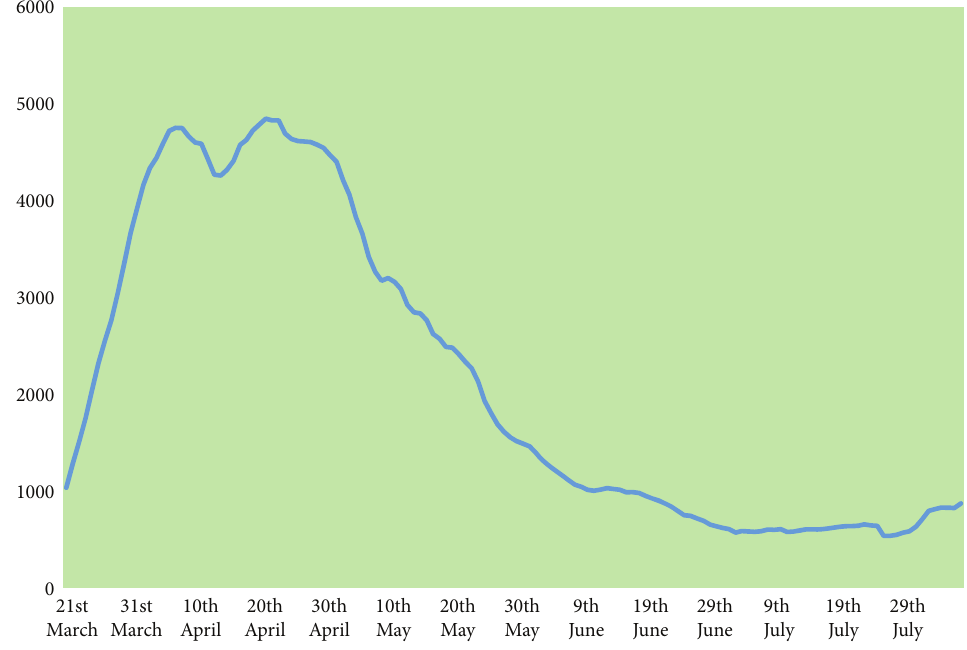
Figure 3: Seven-day moving average new cases, UK COVID